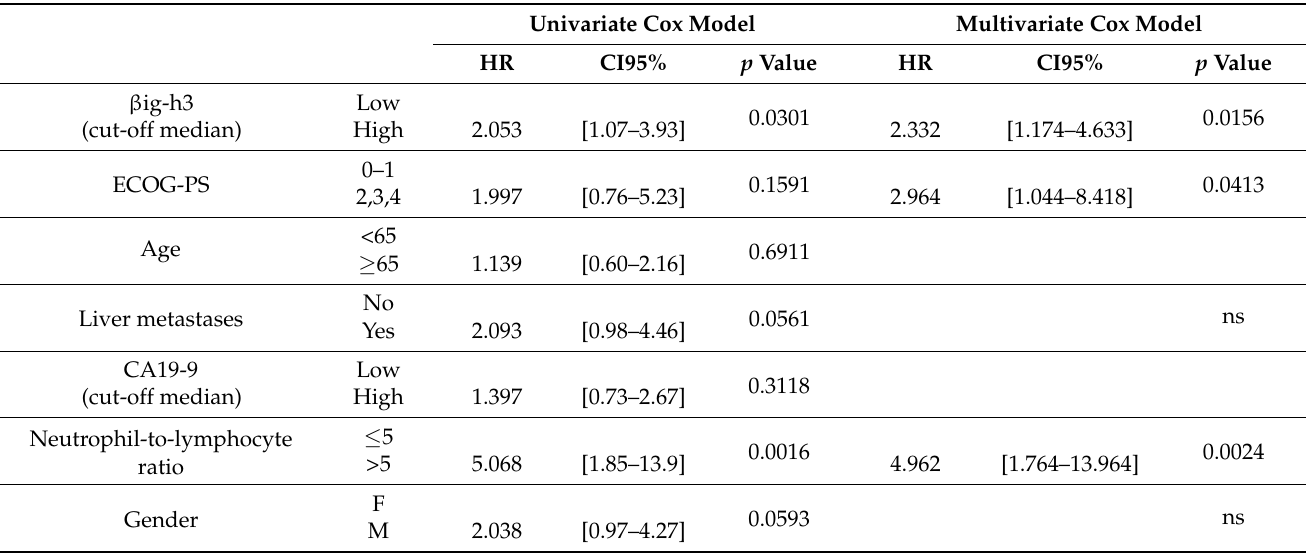
Table 3. Uni- and multi-variate analysis for overall survival (Cox